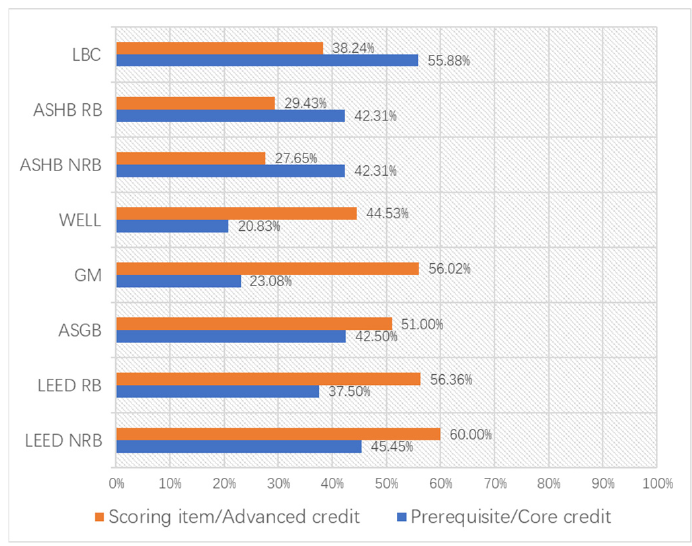
Figure A7. ADR ratios in different GBRSs. (Source: by the author).